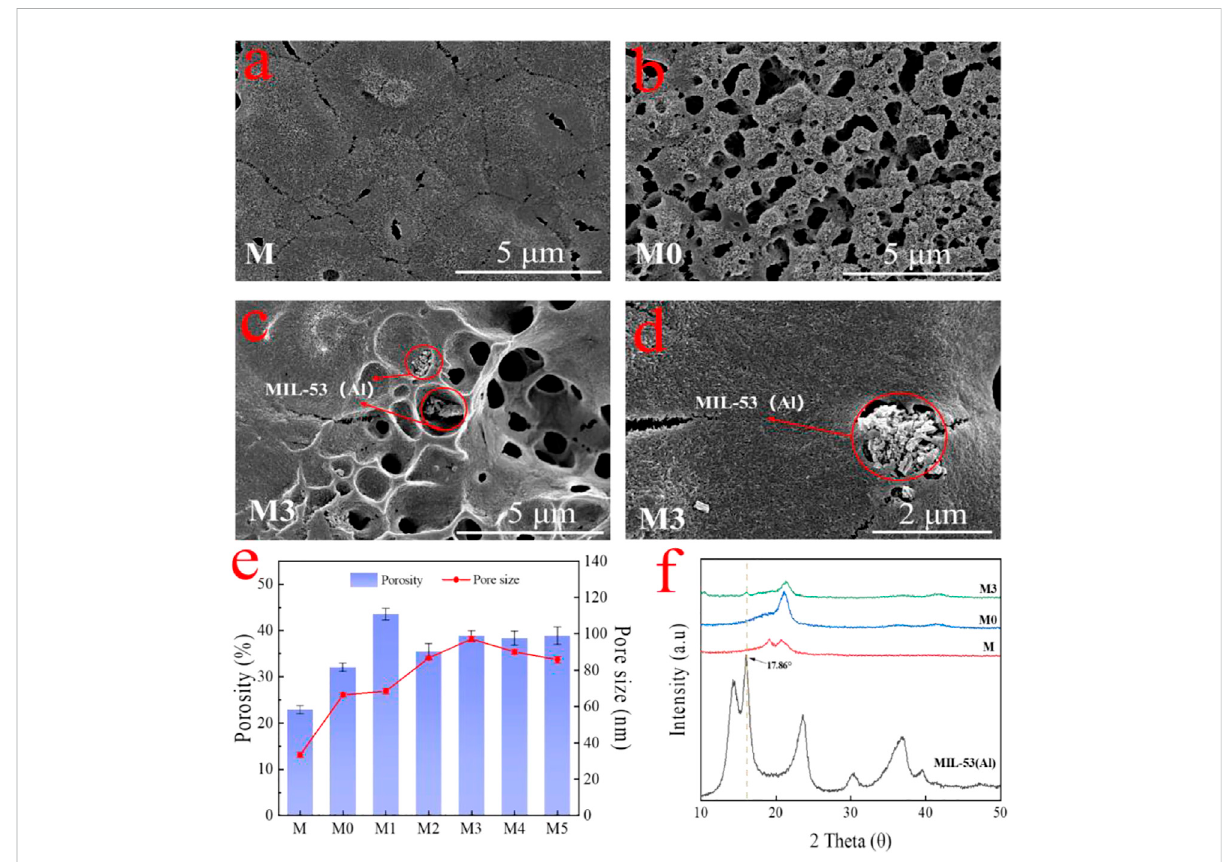
FIGURE 4 The surface morphologies of the (A) M membrane; (B) M0 membrane; (C,D) M3 membrane with different magni fi cations; (E) surface porosity and mean fl ow pore size of membranes; and (F) XRD pattern for the M, M0 and M3